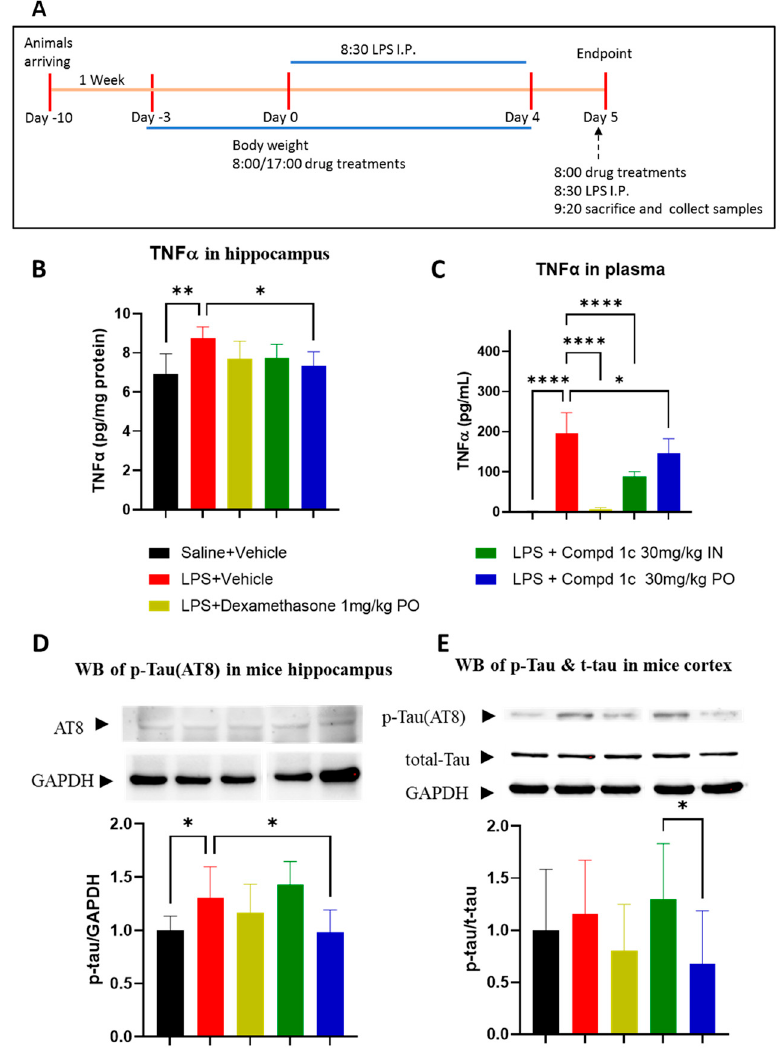
Figure 2. Compound 1c suppresses LPS-induced inflammation. ( A ) Experimental scheme; ( B ) hip- pocampal TNF α protein; ( C ) plasma TNF α ; ( D ) tau phosphorylation in the hippocampus; ( E ) tau phosphorylation in the cortex. * p < 0.05; ** p < 0.01; **** p < 0.0001. Data (means ± SE, n = 6/group) were analyzed by one-way ANOVA.